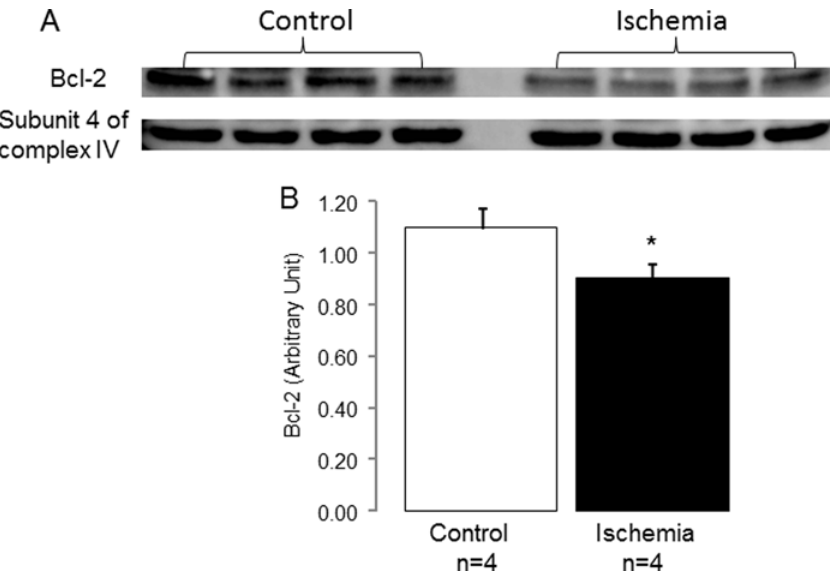
Fig 1. Ischemia decreased bcl-2 content in rabbit SSM. Panel A: Western blotting shows that ischemia markedly decreased bcl-2 content in SSM isolated from rabbit heart compared to non-ischemic hearts. The subunit 4 of cytochrome oxidase was used as protein loading control. Panel B: Ratio of the intensity of bcl-2 over the intensity of subunit 4 of cytochrome oxidase was decreased in ischemia-damaged SSM compared to control (Mean ± SEM; * p < 0.05 vs. control).